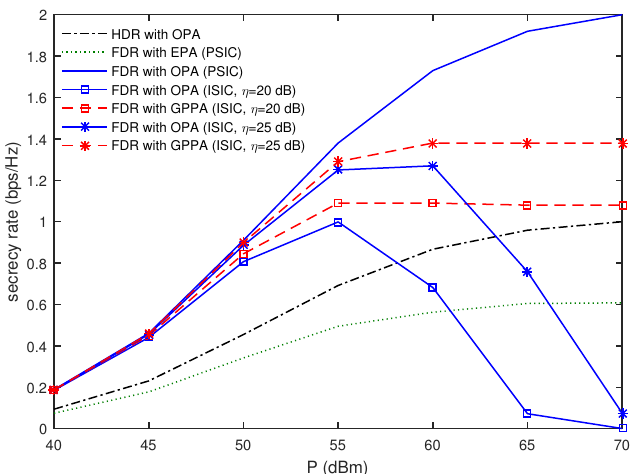
Figure 4. Comparison of secrecy rates as a function of P when T = 4, T E = 2, d Ex = 150 m, and d E = 10 m.